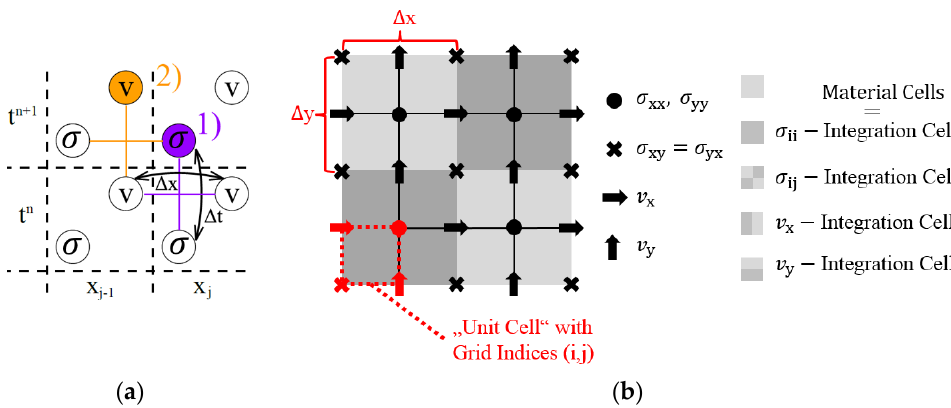
Figure A1. ( a ) The time integration within the velocity-stress EFIT scheme is done by staggering in time, called a leap-frog scheme. ( b ) Spatial grid by staggering of the field variables and integration cells.